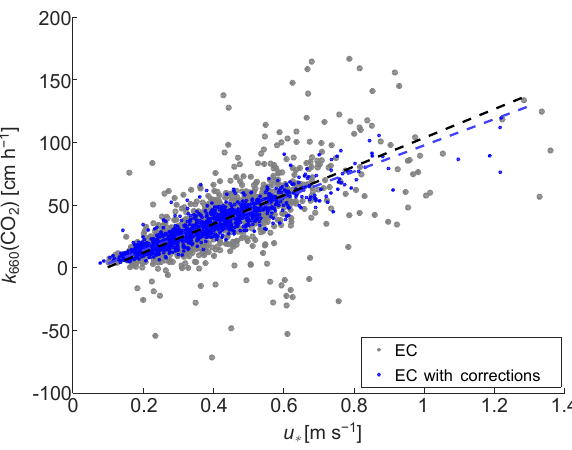
Figure 5. Scatter of the normalised wind speed ( u 10N ) measured by the catamaran (z C = 5 . 6m ) and the wind-speed estimates from the ship: (i) from the bow mast friction velocity (converted via COARE 3.5); (ii) from the bow mast wind speed ( e z b = [9 − 12] m ) ; and (iii) from the AWS anemometer at the crow’s nest (z M = 25 . 6m ) . The lines indicate the mean ratio of the shipborne wind speeds with those from the catamaran. The ratios are 1 . 04 ( ± 0 . 10 ) , 0 . 92 ( ± 0 . 07 ) , and 0 . 85 ( ± 0 . 08 ) for the bow mast momentum flux, and the bow mast and crow’s nest wind speeds, respectively.